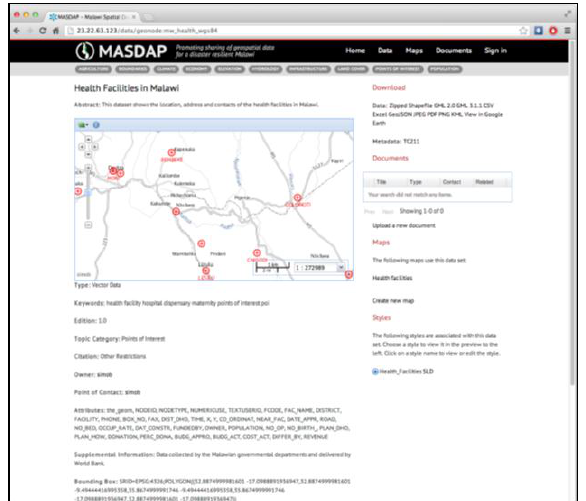
Figure 2. Screenshot of the MASDAP page for Health Facilities